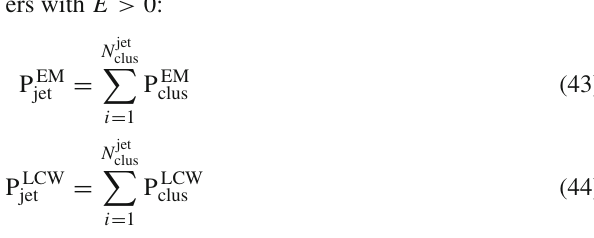
Figure31showsthedistributionsofthenumberoftopo-clust- ) in central, end-cap and forward jets. Distributions ers ( N jet clus are shown using fully simulated pile-up and using data over- lay. The discrepancies between MC simulations and data, while slightly reduced in the simulations employing the pile- up overlaid from data, generally